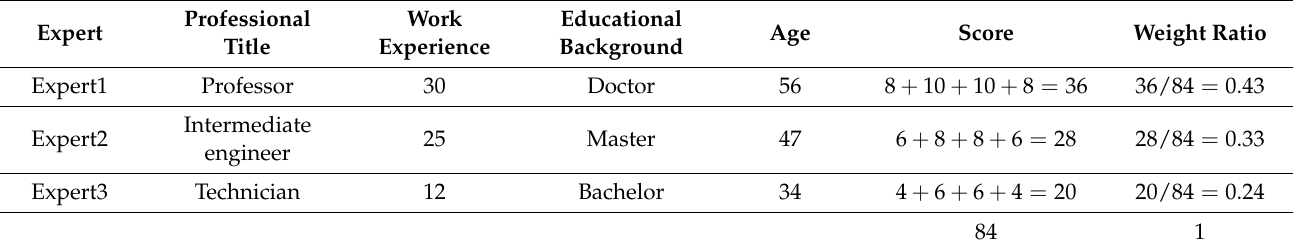
Table 4. Experts’ information and